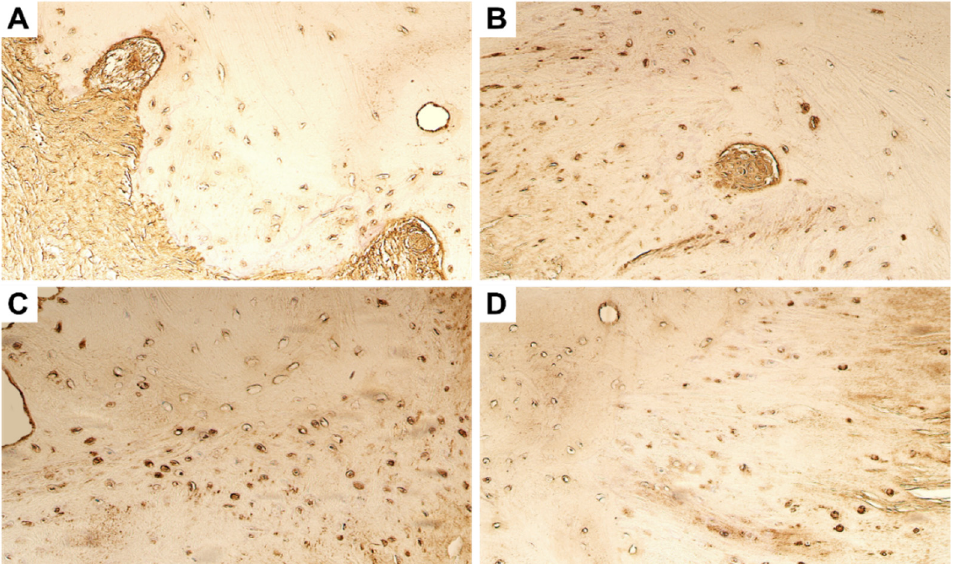
Figure 3. Microphotographs of the ankylotic bone and fibrous cartilage immunohistochemically stained by TIMP-2 and TIMP-4. Numerous TIMP-2-positive osteocytes and chondrocytes in the ( A ) primary surgery tissue material and ( B ) repeated surgery material. Original magnification, 250×. Moderate to numerous TIMP-4-positive cells could be visualized in the tissue obtained during the ( C ) primary surgery and ( D ) repeated surgery. Original magnification, 250×.